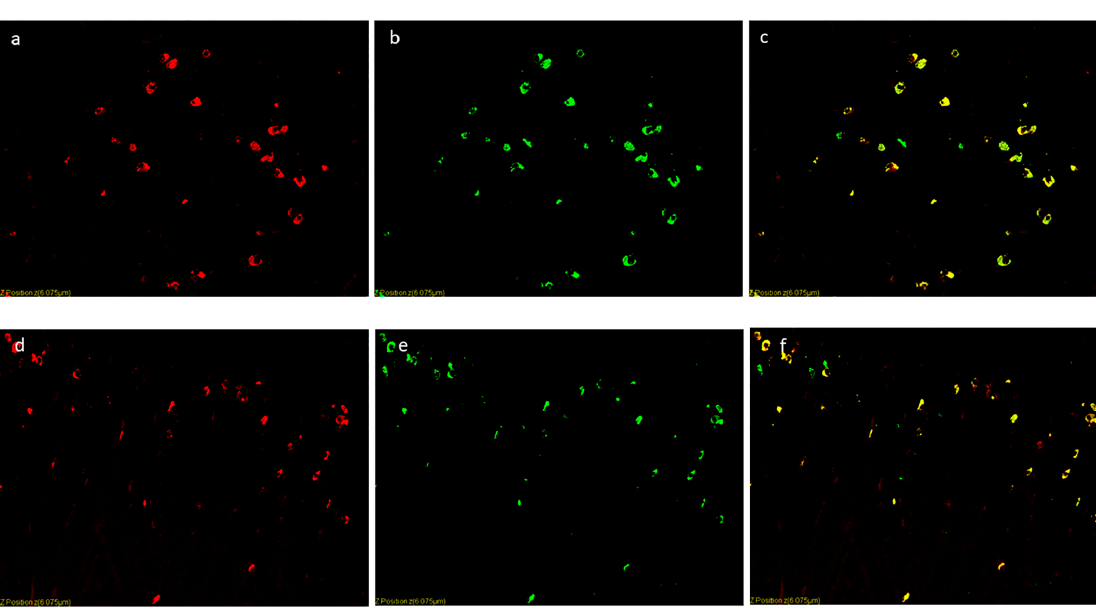
Figure 5. Immunofluorescence findings of the enteroendocrine cells of the proximal duodenum: representative images. Double staining indicates the cytoplasmic localization of chromogranin A, or ghrelin and α -tran. ( a ) CTR, the red color is α -tran; ( b ) CTR, the green color is chromogranin A; ( c ) CTR, the red color is α -tran, the green color is chromogranin A and the yellow color is colocalization. ( d ) T2, the red color is α -tran; ( e ) T2, the green is color ghrelin; ( c ) T2, the red color is α -tran, the green is color ghrelin and yellow color is colocalization.